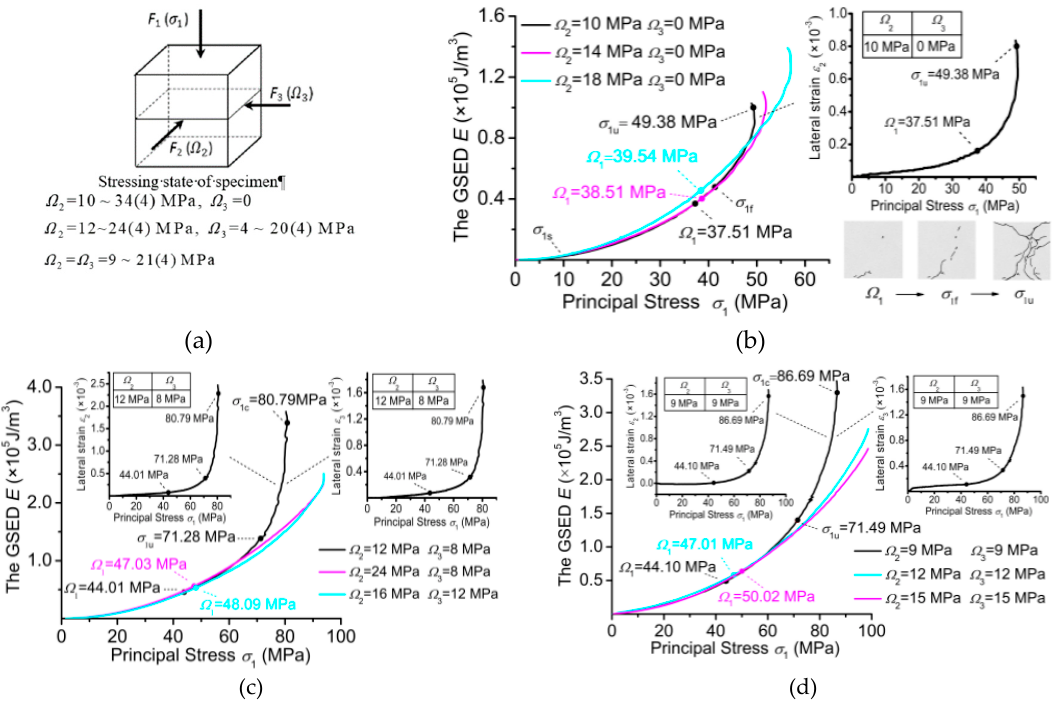
Figure 2. The E − σ 1 curves and the characteristic points. ( a ) The triaxial stress state of a specimen. ( b ) The E − σ 1 curves of the biaxial specimens with their characteristic points σ 1s and Ω 1 , and the lateral strain σ 1 curve ( Ω 2 = 10 MPa, Ω 3 = 0) with the characteristic points ( Ω 1 , σ 1u and σ 1u close to Ω 1 ) to their cracking profiles. ( c , d ) The E − σ 1 curves of the triaxial specimens, and two lateral strain- σ 1 curves ( Ω 2 = 9 MPa, Ω 3 = 8 MPa; Ω 2 = Ω 3 = 9 MPa) with their characteristic points ( Ω 1 , σ 1c